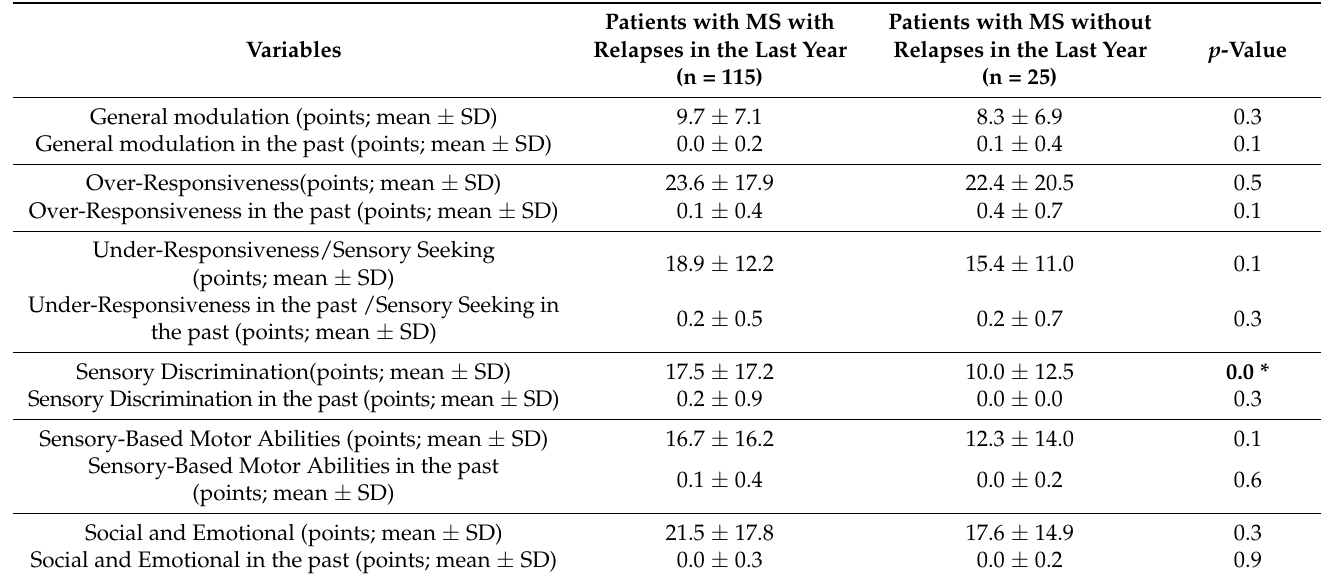
Table 2. A detailed analysis of the severity of sensory integration disorders in patients with MS with relapses during the last year and without relapses.